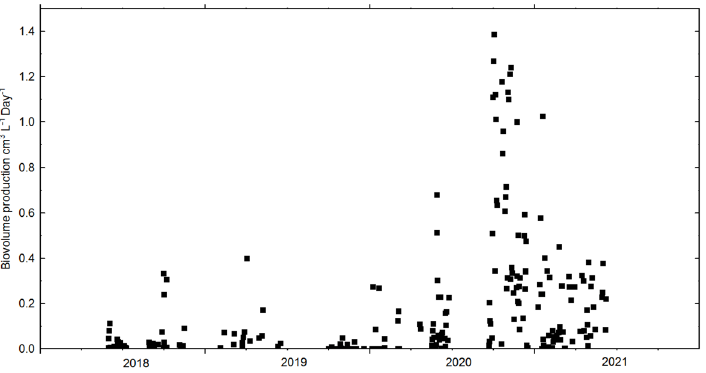
Figure 12. Production measured as biovolume in the 300,000 L reactor.